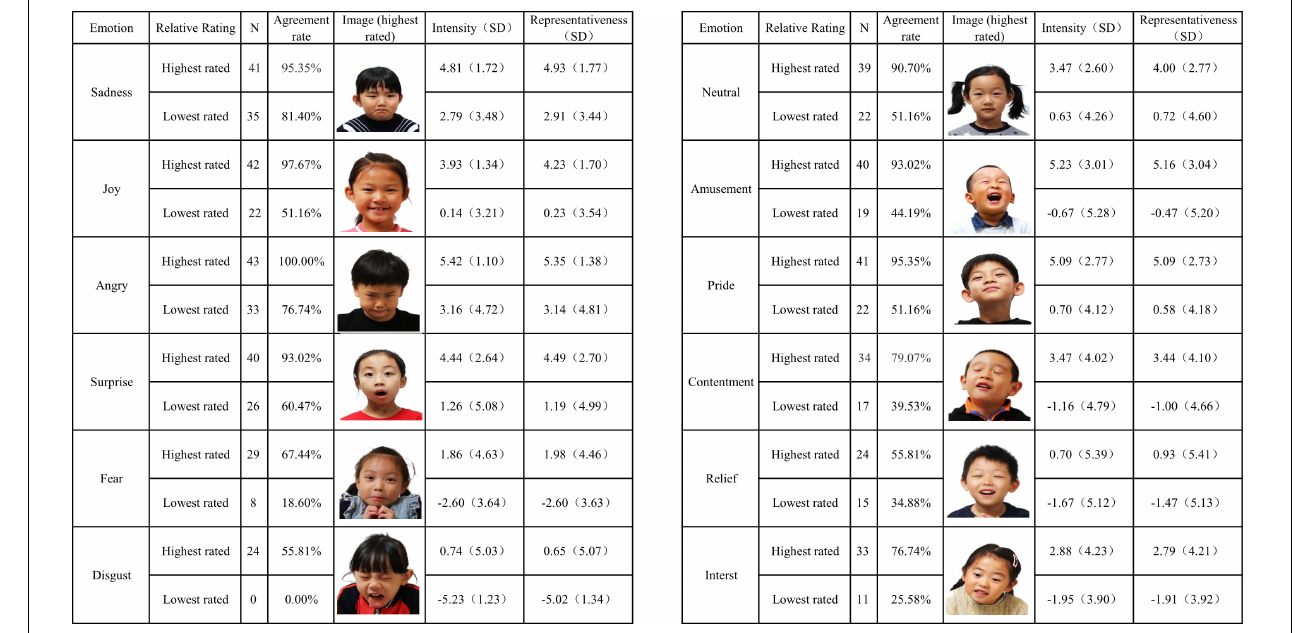
FIGURE 2 | Intensity and representativeness ratings for images with the highest and the lowest percent agreement, by emotion condition; SD = standard deviation.